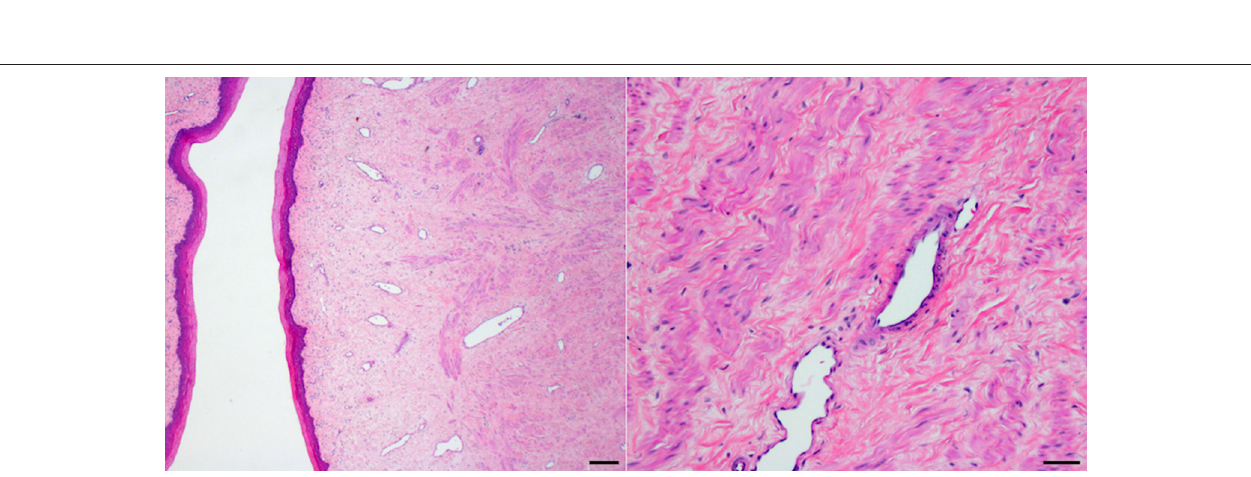
Frontiers in Veterinary Science |